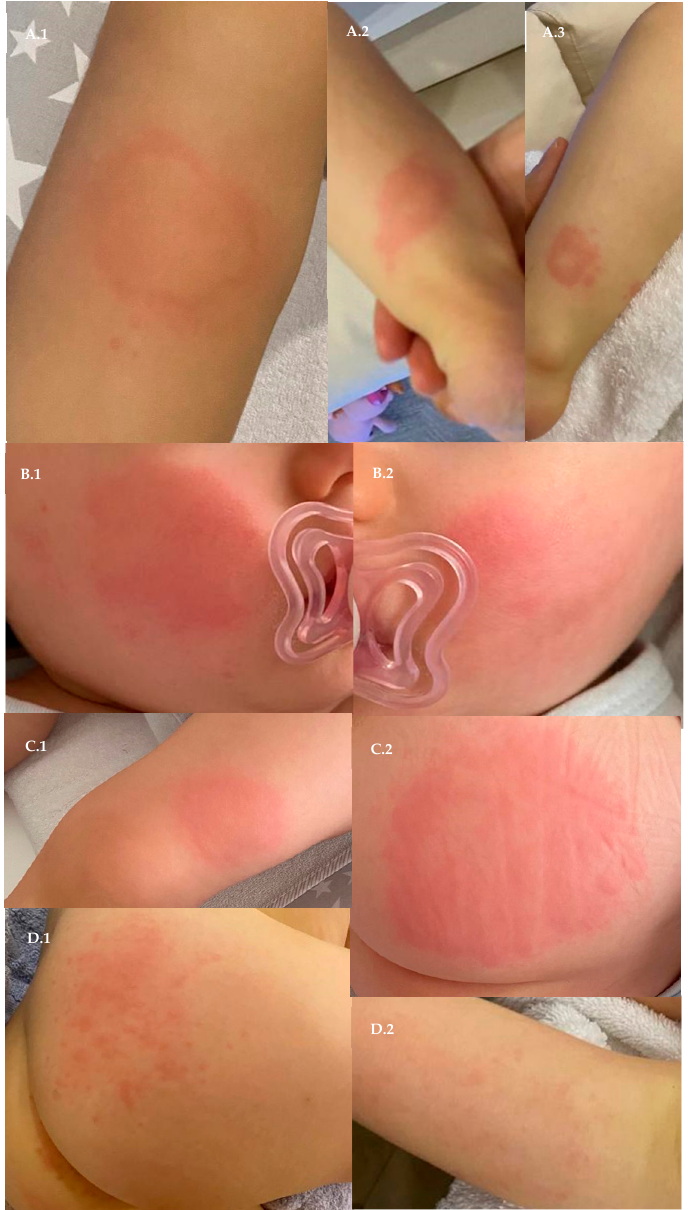
Figure 1. Cutaneous reaction images in a breastfed, 16 ‐ month ‐ old female infant. Photographs of all lesions are presented from day two until day six after the first dose of the AstraZeneca vaccine. Some photographs were taken using a mirror, so left and right images might be rearranged.